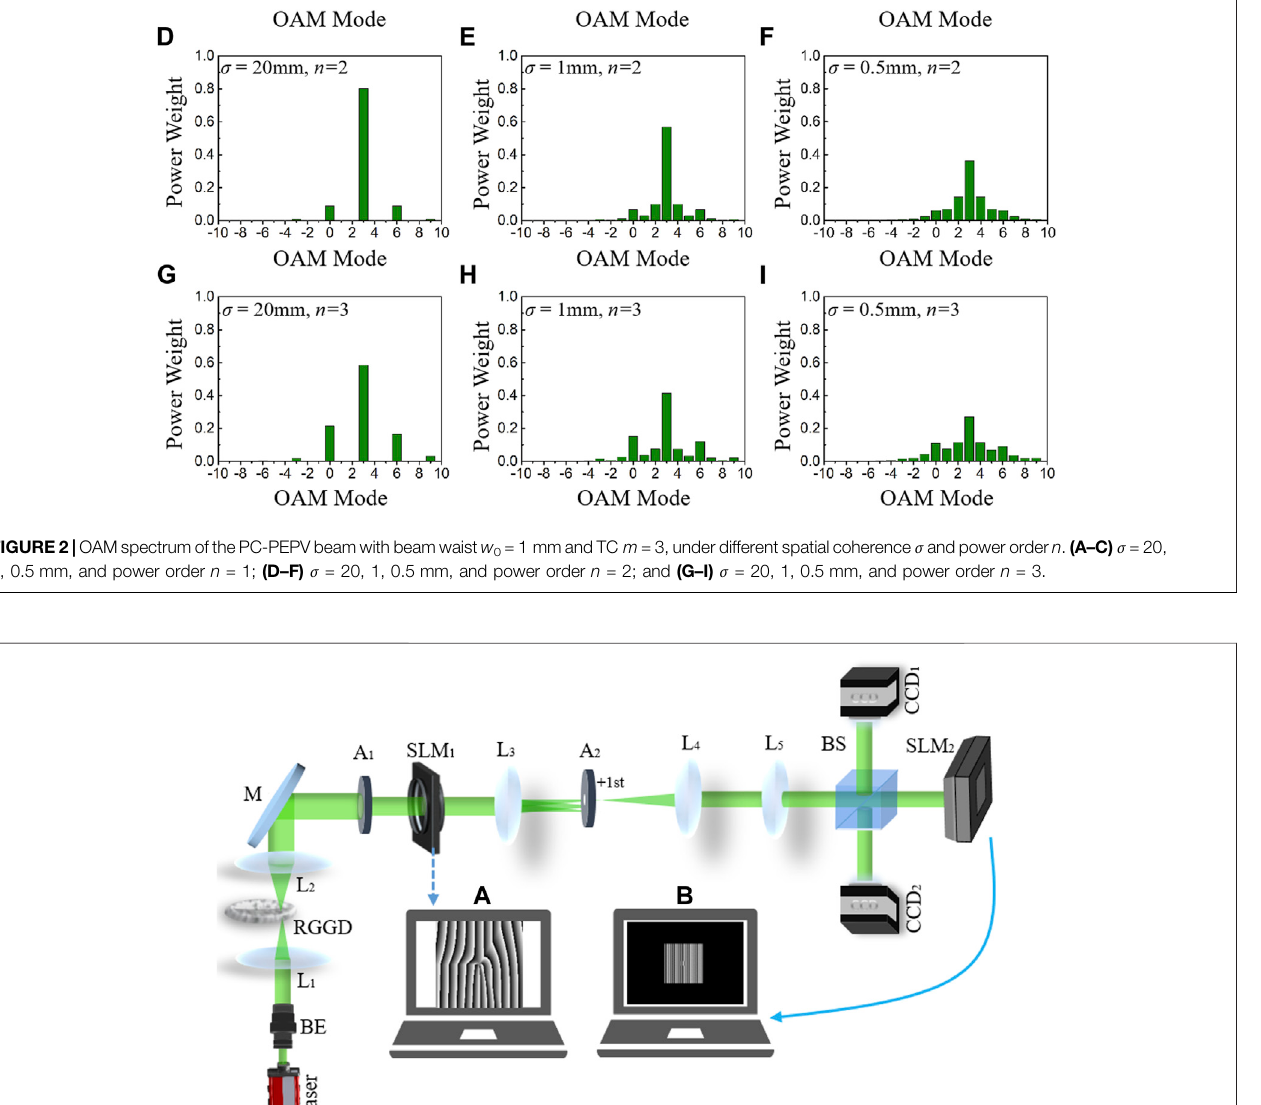
Frontiers in Physics |